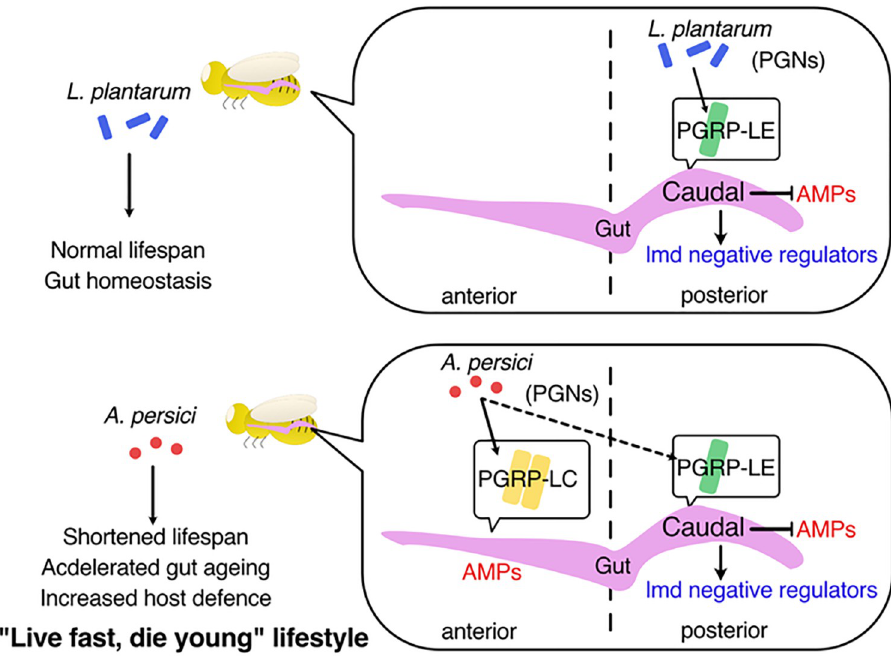
Fig 9. Graphical summary of this